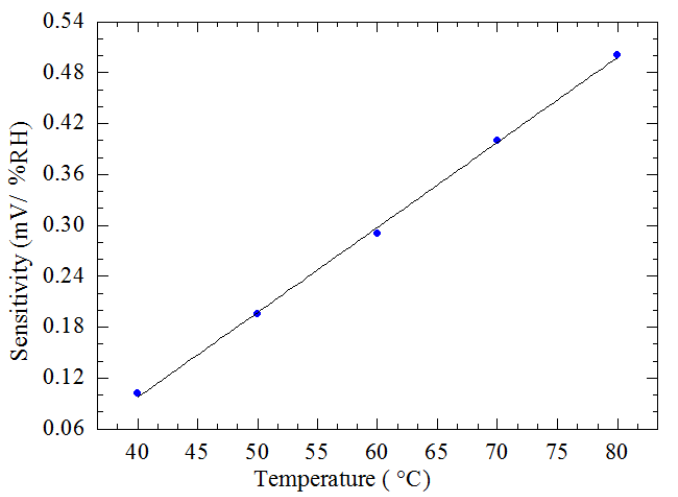
Figure 10. Sensitivity of the CMOS-MEMS humidity sensor vs. temperature.